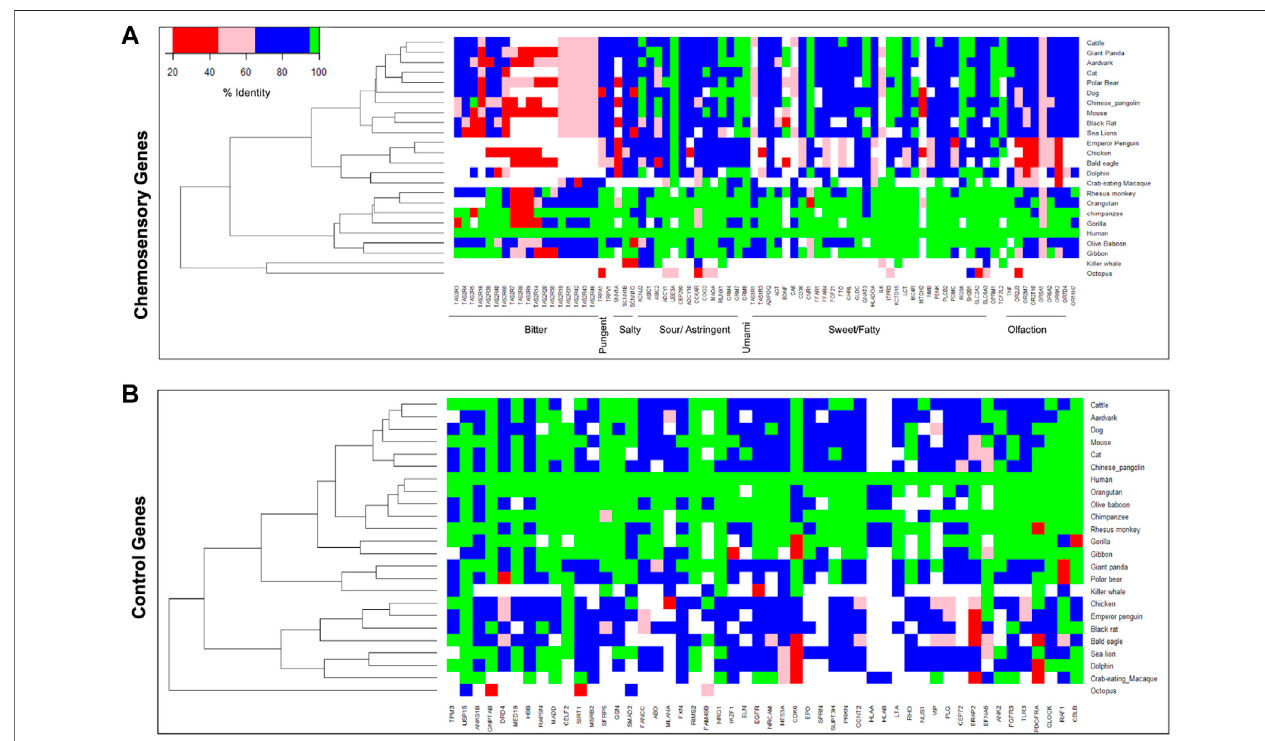
FIGURE4| Heatmapsrepresenttheproteinsequencediversityof (A) chemosensoryperception-associatedgenesand (B) thecontrolsetofgenesacrossdifferent species. The color represents lower (red) to higher (green) protein sequences conservation.